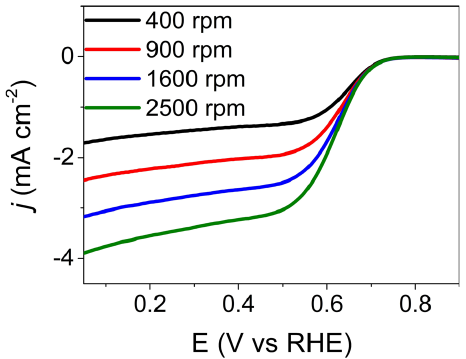
saturated 0.1 M KOH at 10 mV s -1 and Figure 6. ORR curves in O 2 different electrode rotation rates for T-graphene.